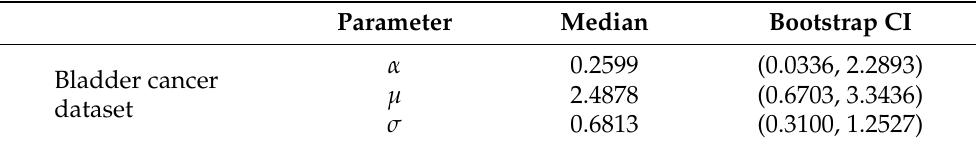
Table 14. The median and 95% bootstrap confidence interval for the GDUSLN parameters on bladder cancer